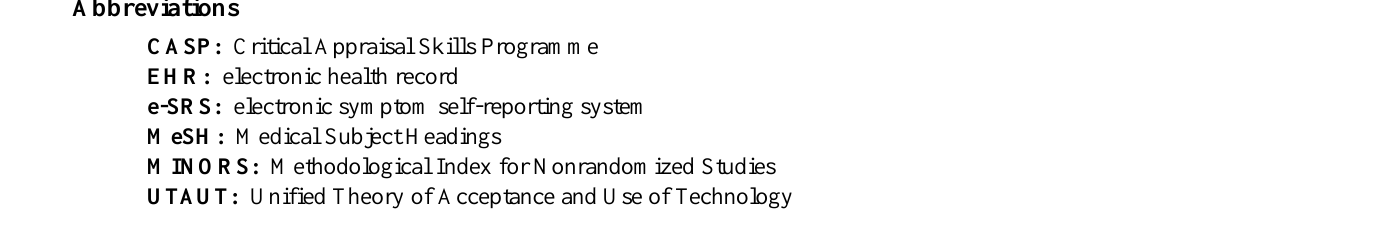
UTAUT: Unified Theory of Acceptance and Use of